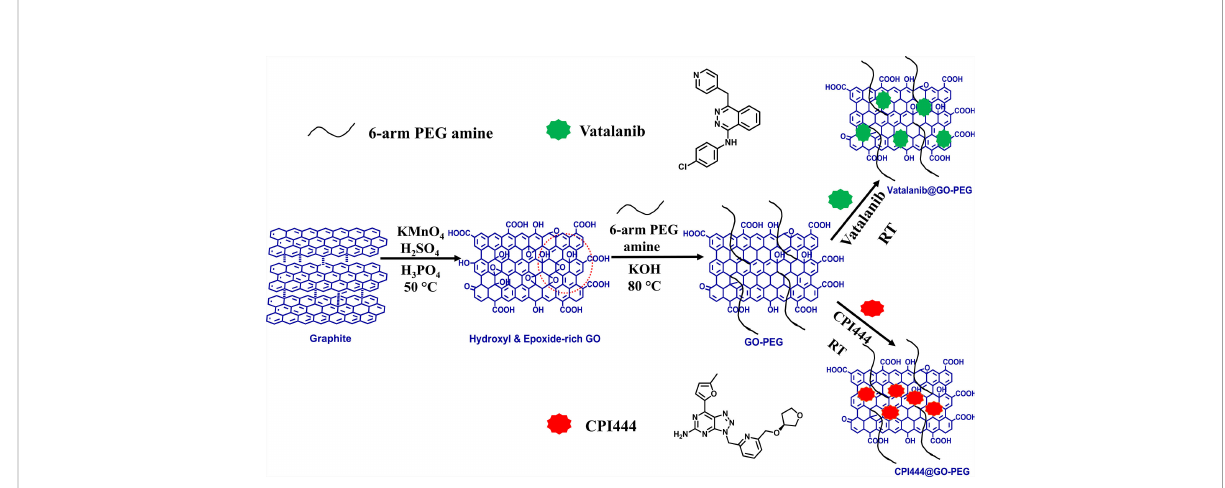
FIGURE 1 Schematic diagram for the synthesis of GO, GO-PEG, and drug loaded GO-PEG nanocarriers (CPI444@GO-PEG and